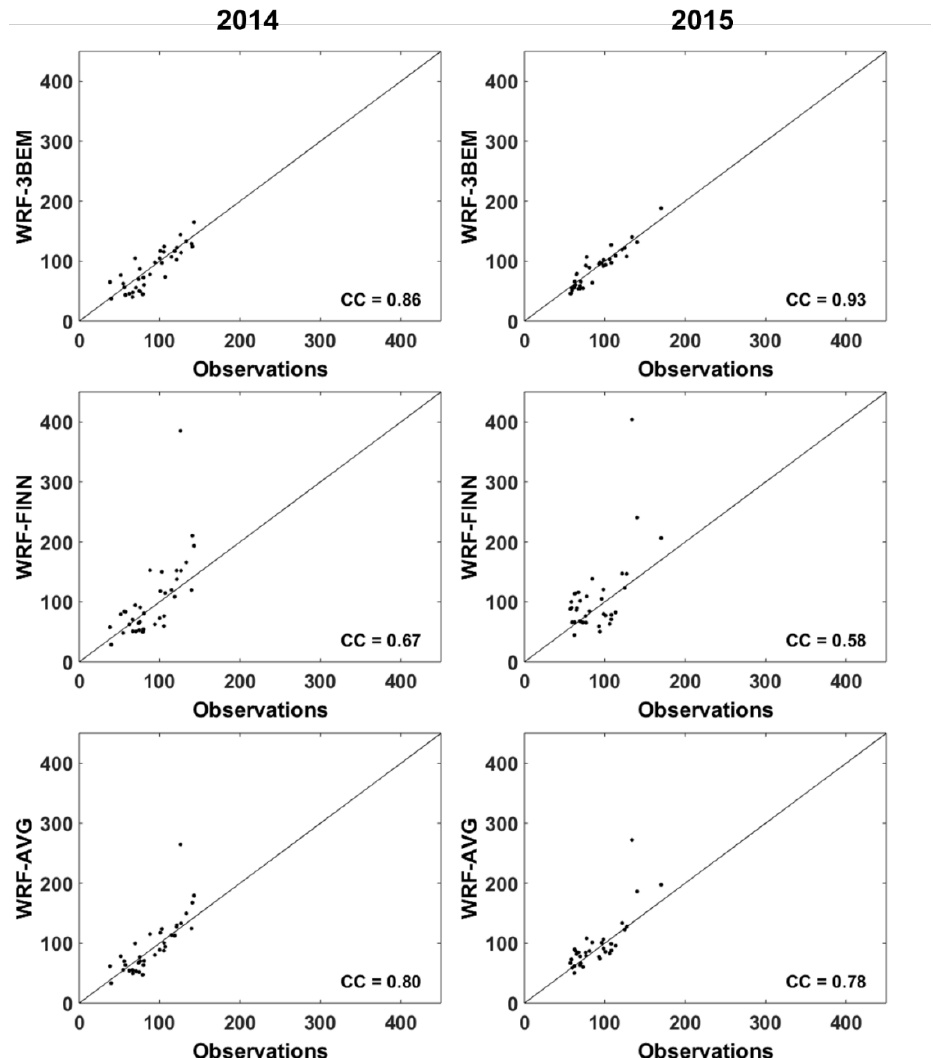
Figure 15. Scatter plots comparing measured monthly average PM10 concentrations (μg m −3 ) and simulations of WRF-3BEM, WRF-FINN, and WRF-AVG for February–April 2014 and